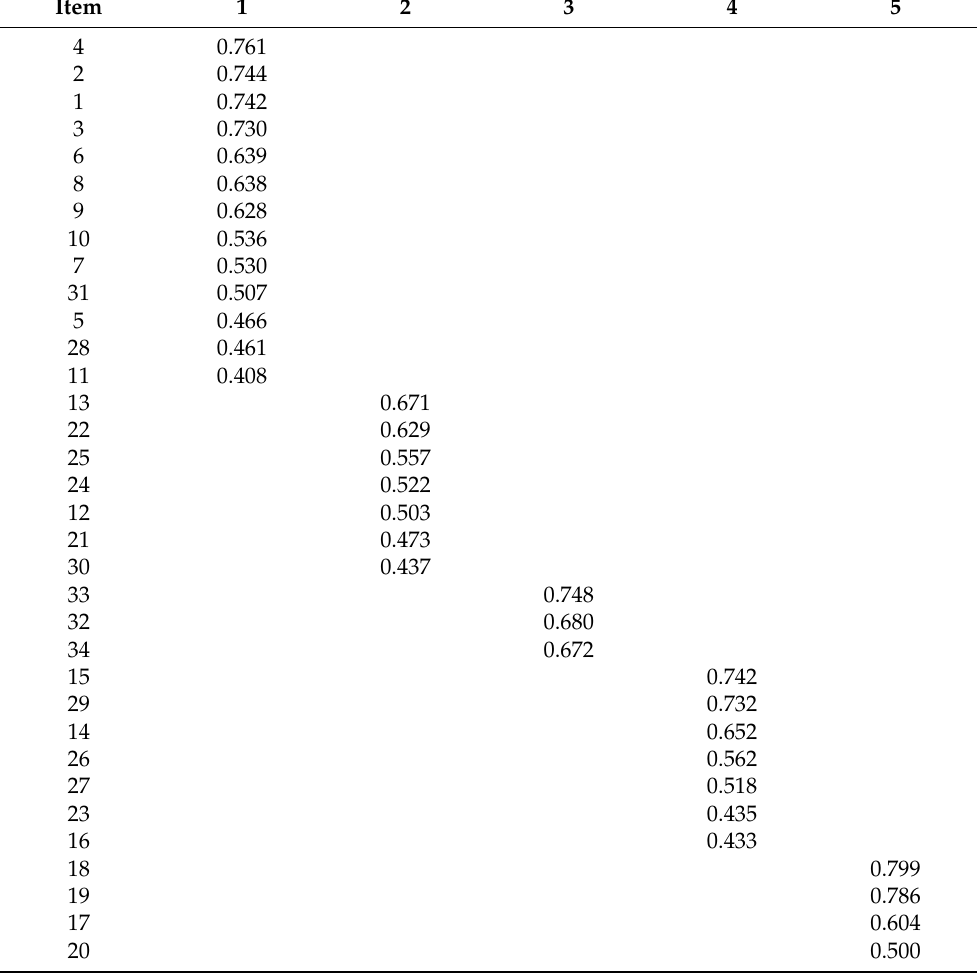
Table 2. Pattern matrix of CECVS—experiencing cyber-violence subscale.